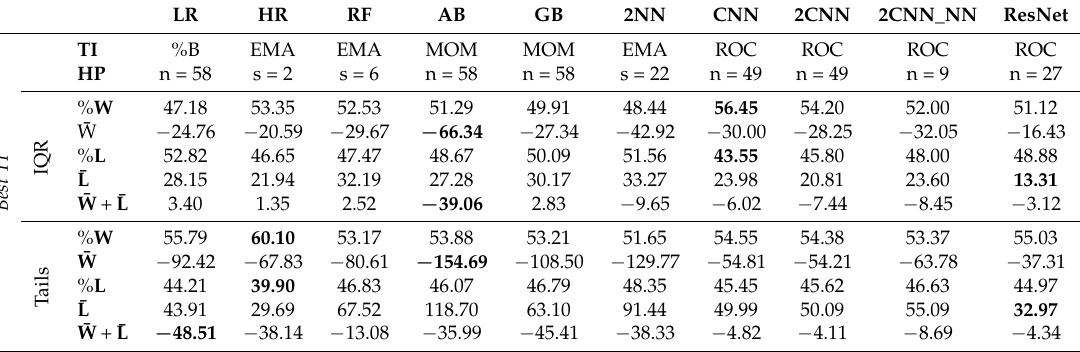
Table 2. Results highlighting differences between TI and benchmark model squared errors for targets inside the interquartile range (IQR) and outside the IQR (Tails). Bold values are used to highlight the highest